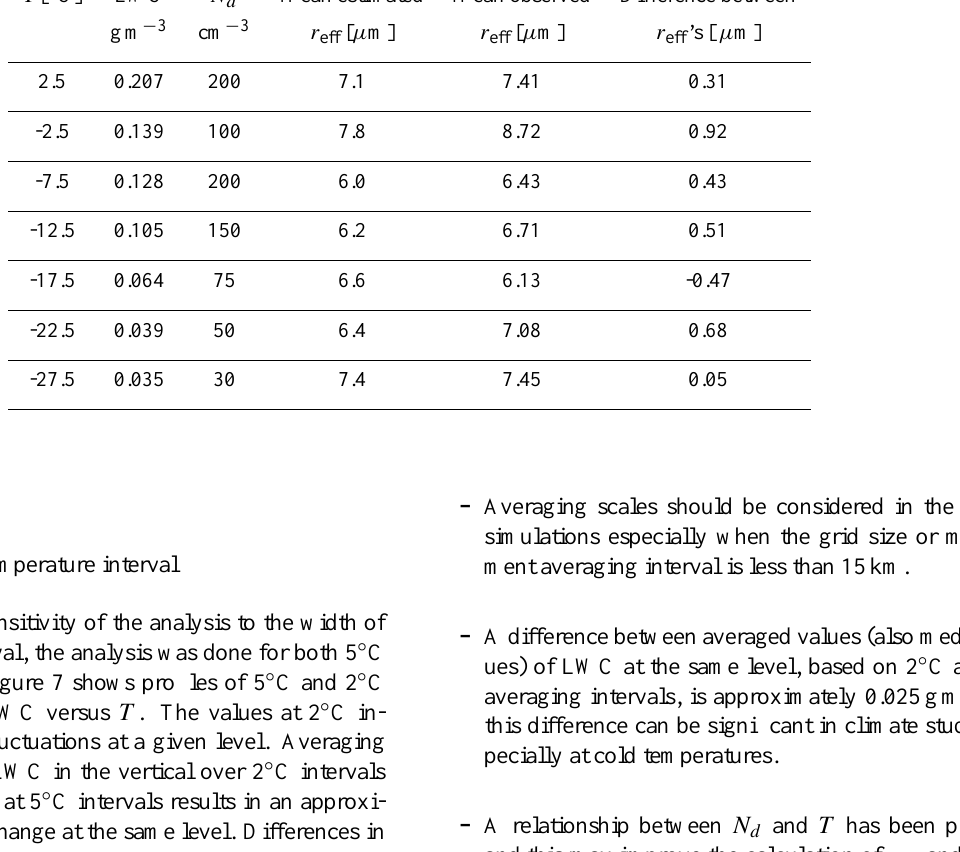
Table 3. Effective radius calculated from AIRS observations and from Eq. (1) that utilized k, = 0 . 72, mean LWC and N d T [ ◦ C] LWC N d Mean estimated Mean observed Difference